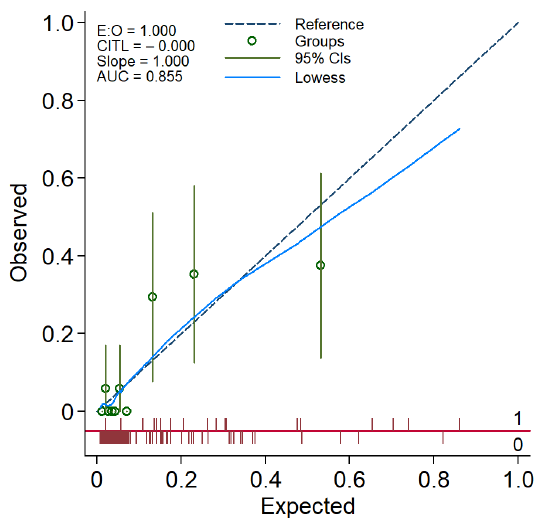
Figure 4. A calibration plot demonstrating the performance of the FibRO-3 model. The expected risk of significant liver fibrosis (stage ≥ 2) is divided into 10 equally sized groups (of tenths). The green circles and spikes on the diagonal line are average predicted risks and 95% confidence bands, respectively. The dotted straight line represents the reference line of the model’s calibration. The blue line connecting the green circles is the locally weighted scatterplot smoothing